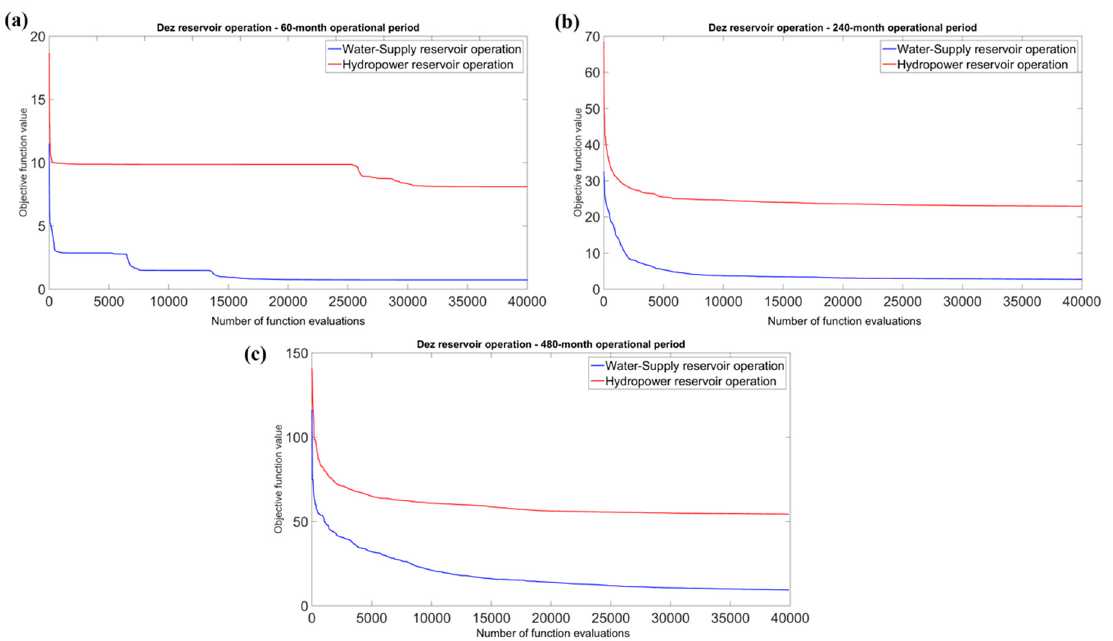
Figure 5. Convergence curve of the optimum solution obtained by the CSS algorithm for “Dez” reservoir water-supply and hydropower operation, considering evaporation losses, over 60 ( a ), 240 ( b ) and 480 ( c ) months periods.